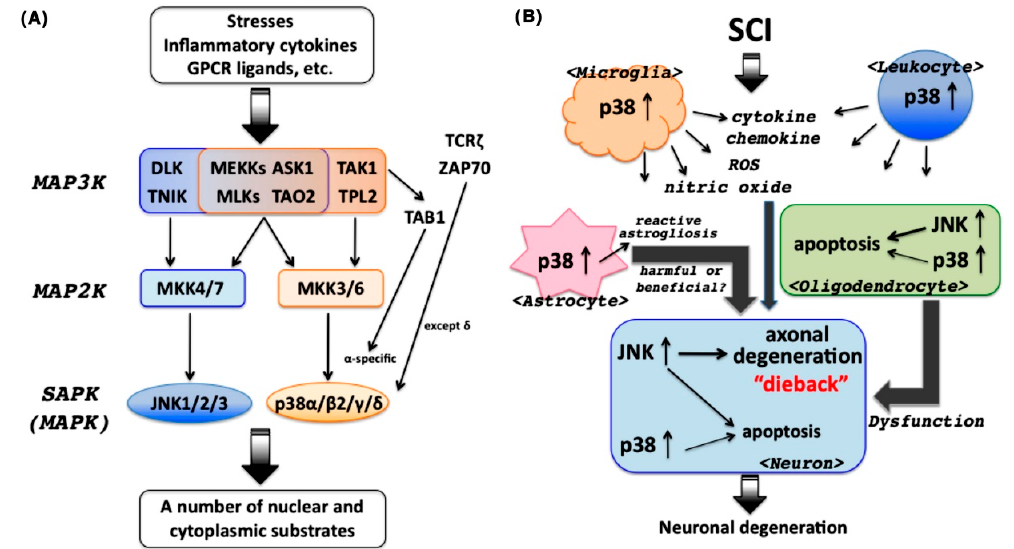
Figure 1. ( A ) Overview of the stress-activated protein kinase (SAPK) pathway. SAPKs, c-Jun N-terminal kinases (JNKs), and p38 mitogen-activated protein kinases (MAPKs) are activated in response to a variety of cellular stresses through a three-step pathway (MAP3K/MAP2K/MAPK). In addition to this canonical pathway, several pathways for p38 activation have been demonstrated. ( B ) Overview of the SAPK-mediated neuronal degeneration after spinal cord injury (SCI). JNK contributes to neuronal degeneration in a direct manner and also induces neuronal dysfunction in an indirect manner through oligodendrocytic cell-death-associated demyelination. p38 predominantly orchestrates SCI-triggered inflammatory responses such as activation of microglia, production of inflammatory and neurotoxic mediators from infiltrated leukocytes and activated microglia, and reactive astrogliosis. Reactive astrogliosis shows bidirectional effects on neuronal regeneration after SCI.